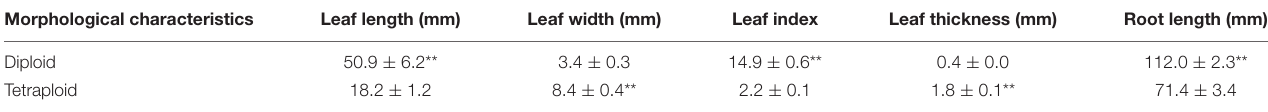
TABLE 5 | Morphological characteristics of diploid and tetraploid garlic.